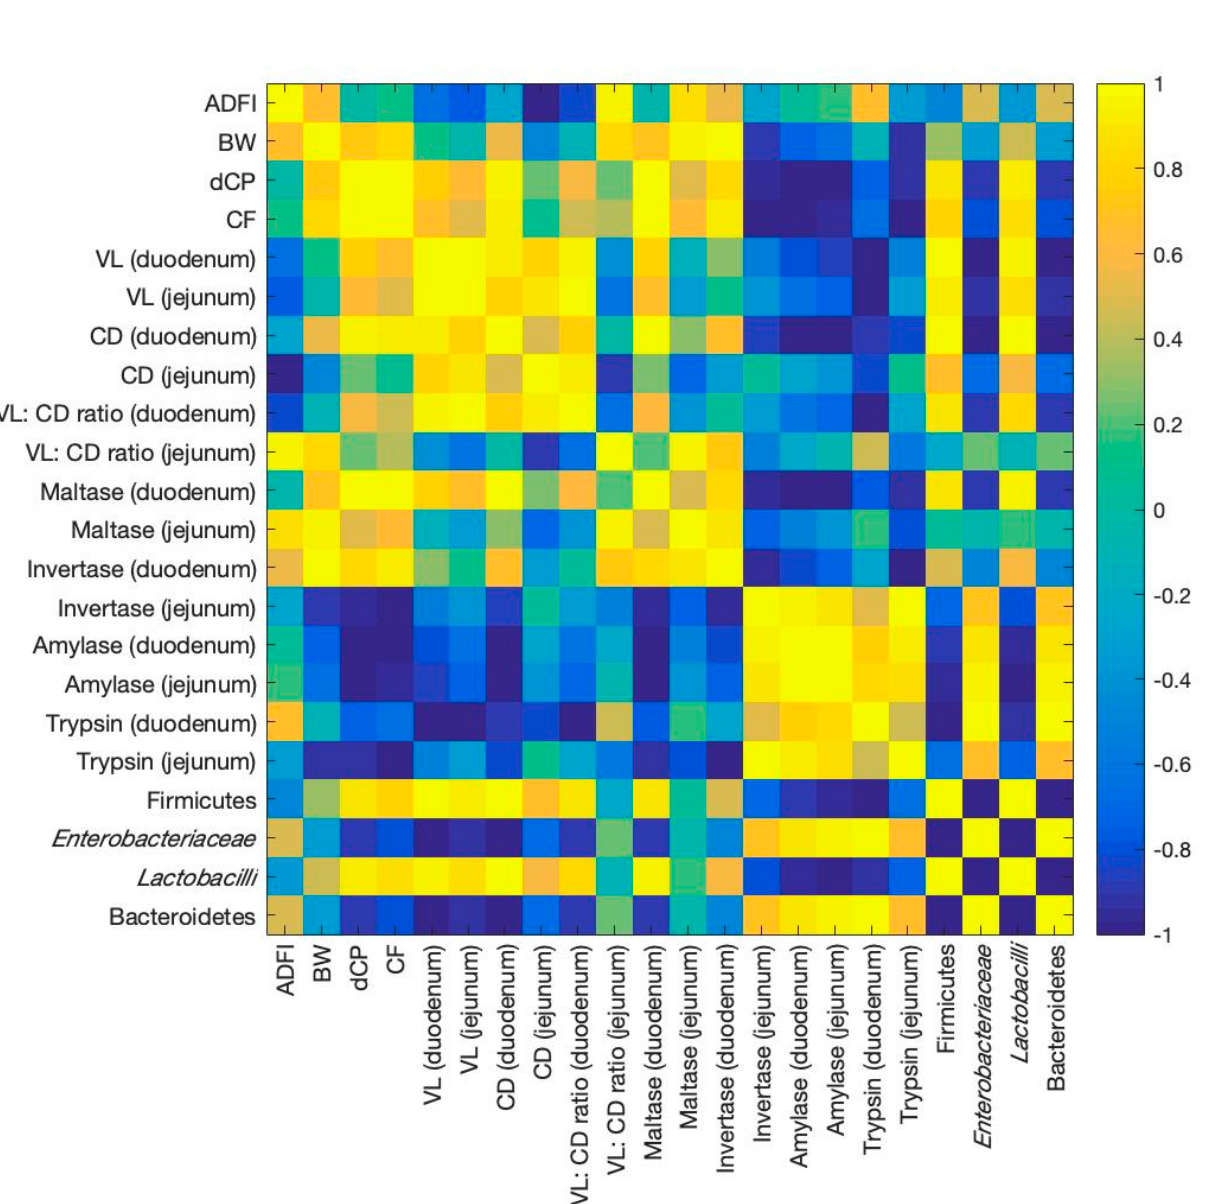
Figure 6. A heatmap showing Pearson’s correlations between multiple parameters, predominant genera in the duodenum, jejunum, and intestinal morphology. Yellow indicates a positive correlation; blue indicates a negative correlation. Abbreviations: VL, villous length; CD, crypt depth; VL: CD, villous length: crypt depth.